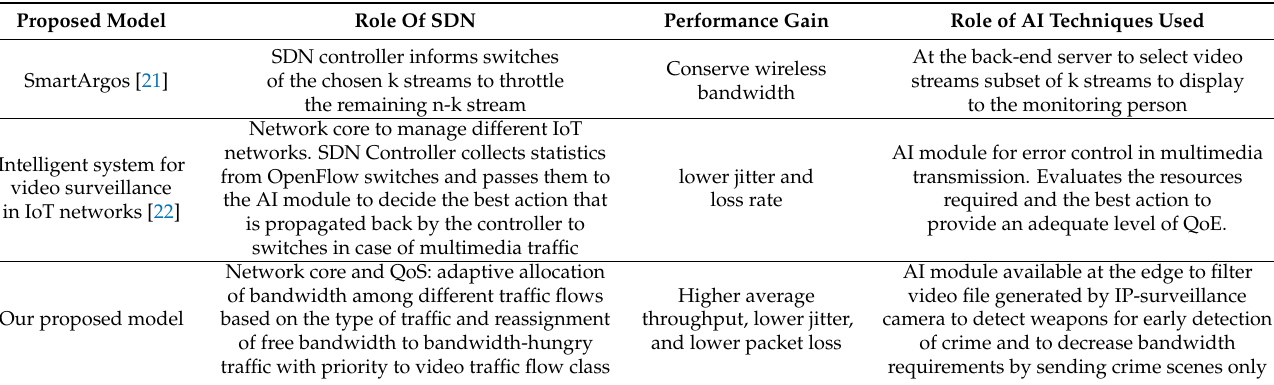
Table 1. Literature Review of SDN-based Video Surveillance